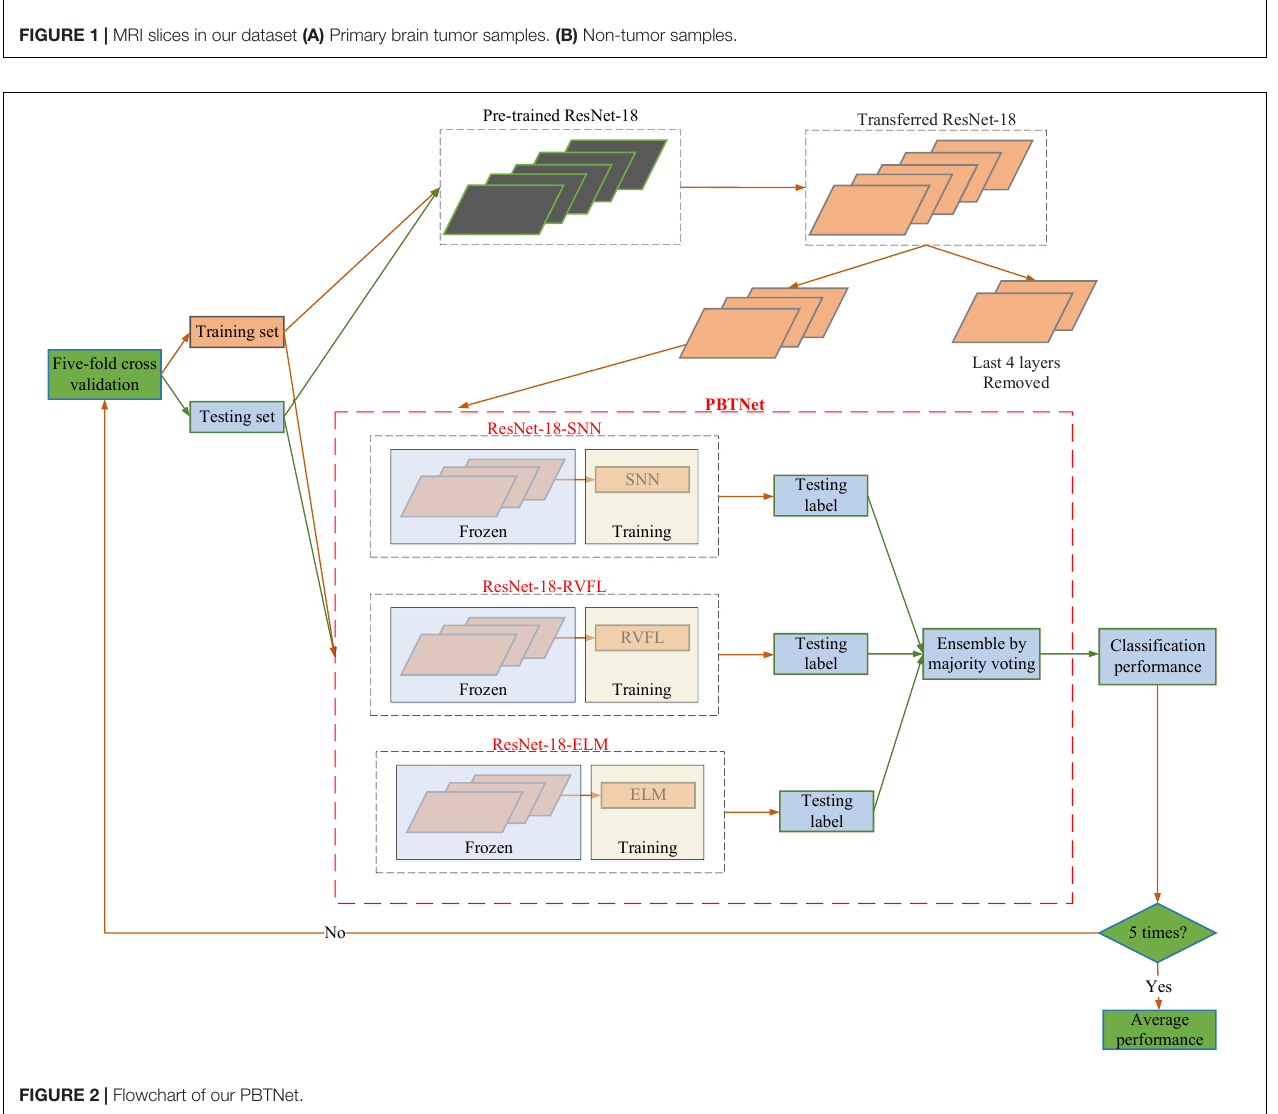
FIGURE 2 | Flowchart of our